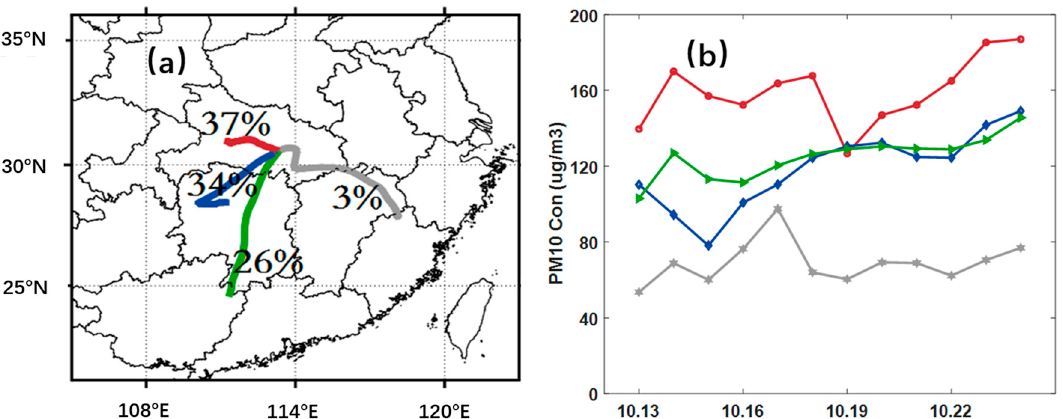
Figure 9. ( a ) Examples of the air mass analysis for October 13–25, 2015. The percentage for each trajectory represented the air mass contributions. ( b ) PM 10 concentrations on the monitoring sites corresponding to each trajectory line. The four colored trajectories in ( a ) correspond to each line in ( b ).